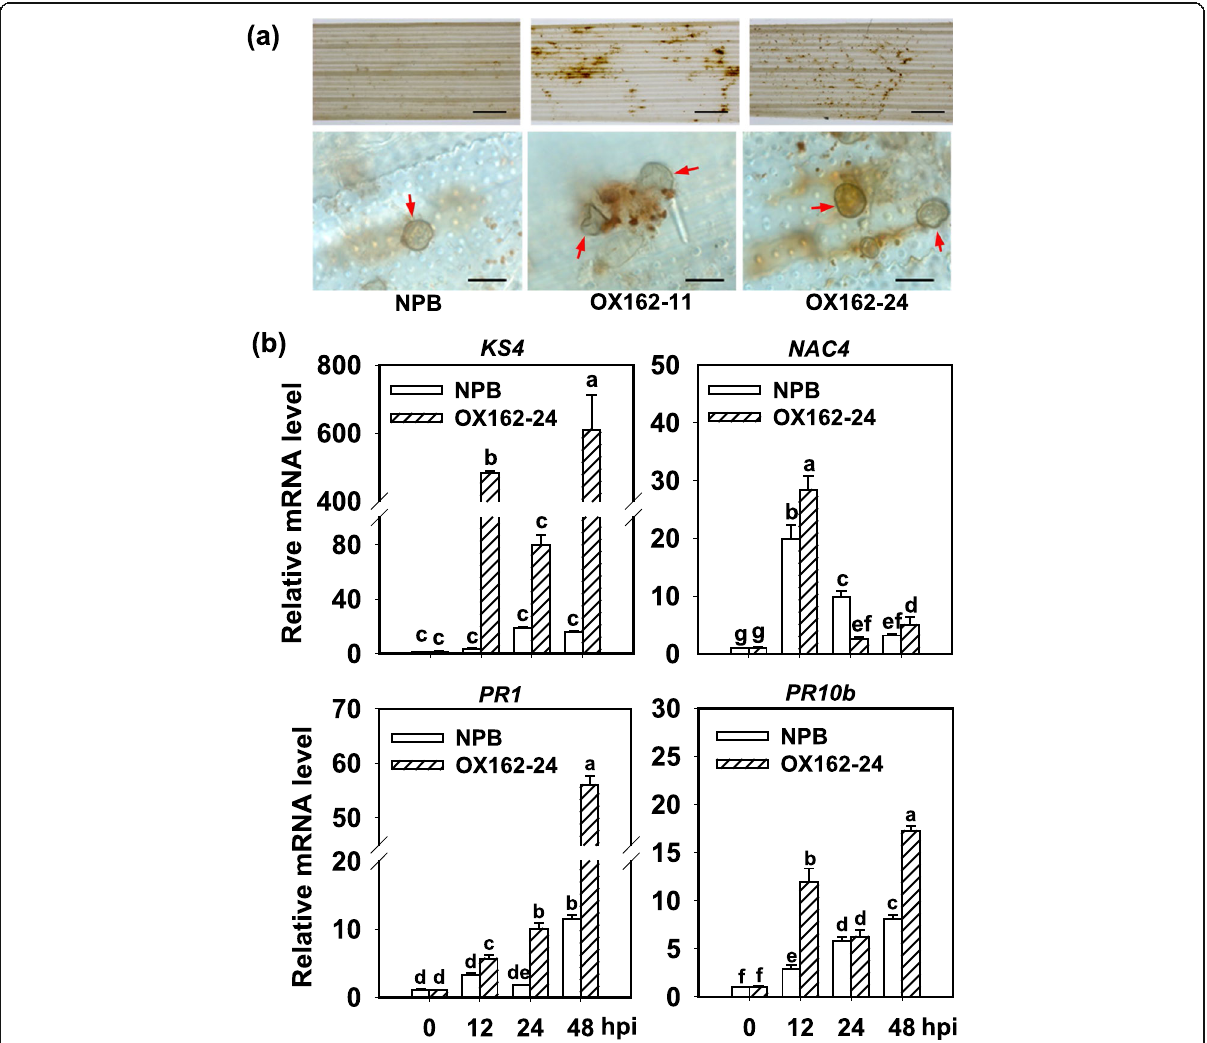
Fig. 3 Osa-miR162a enhances the induction of disease-related defense responses. a Hydrogen peroxide (H 2 O 2 ) accumulation in wild type (Nipponbare, NPB) and OX162 at 48 h post-inoculation (hpi) of M. oryzae strain GZ8. The intensity of brown indicates the amounts of H 2 O 2 , which was stained by 3,3 ′ -diaminobenzidine (DAB). The red arrows indicate appressoria formed from conidia. The above photos were taken with a stereo-microscope, scale bars = 1 mm. The photos at the down portion were taken with a microscope (Zeiss imager A2), scale bars = 40 μ m. b Relative mRNA levels of the defense-related genes ( OsKS4, OsNAC4, OsPR1 , and OsPR10b ) in NPB and OX162 following inoculation of M. oryzae GZ8. Rice ubiquitin ( UBQ ) gene was served as an internal reference. The mRNA levels were normalized to that in NPB at 0 hpi. Error bars indicate SD (n = 3). Different letters above the bars indicate significant differences ( P < 0.05) as determined by One-way ANOVA analysis. Similar results were obtained in at least two independent